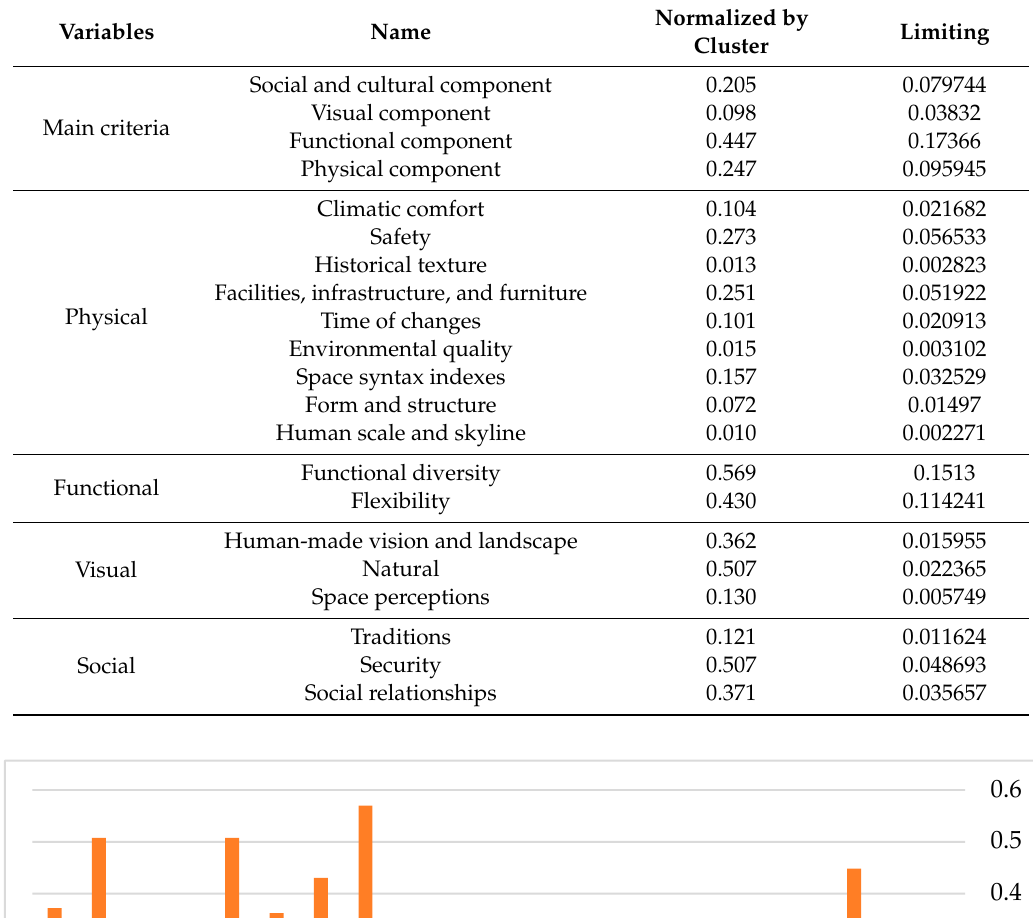
Table 11. Weighted super matrix and the limit of criteria and sub-criteria.